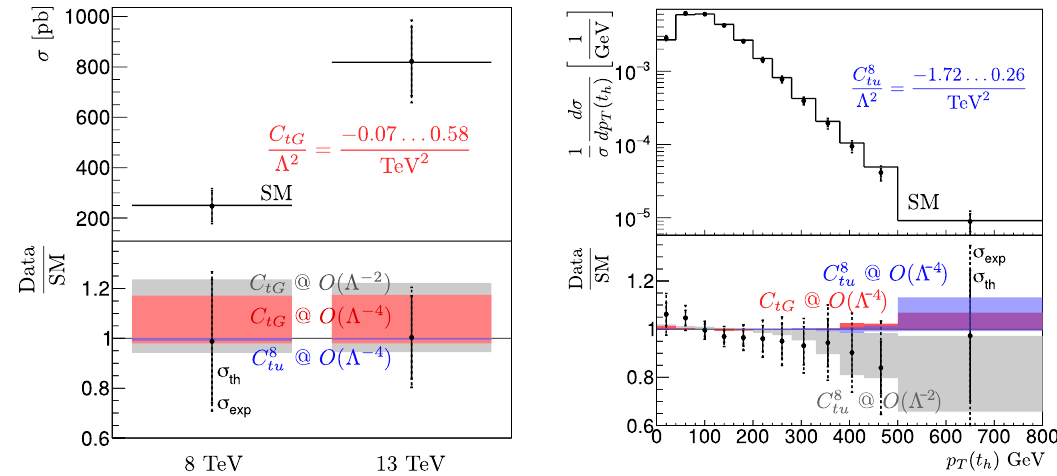
Figure 3 . Contribution of O tG and O 8 to total t (cid:22) t rates (left) and the normalized p T distribution tu of a hadronically decaying top (right). The shaded regions correspond to the 68% CL from a simultaneous (cid:12)t to the two rates and the distribution. The grey shaded regions show the contribution from O tG (rates) and O 8 (distribution) at order (cid:3) (cid:0) 2 . The red and blue shaded regions show the tu contribution from O tG and O 8 to order (cid:3) (cid:0) 4 , tu